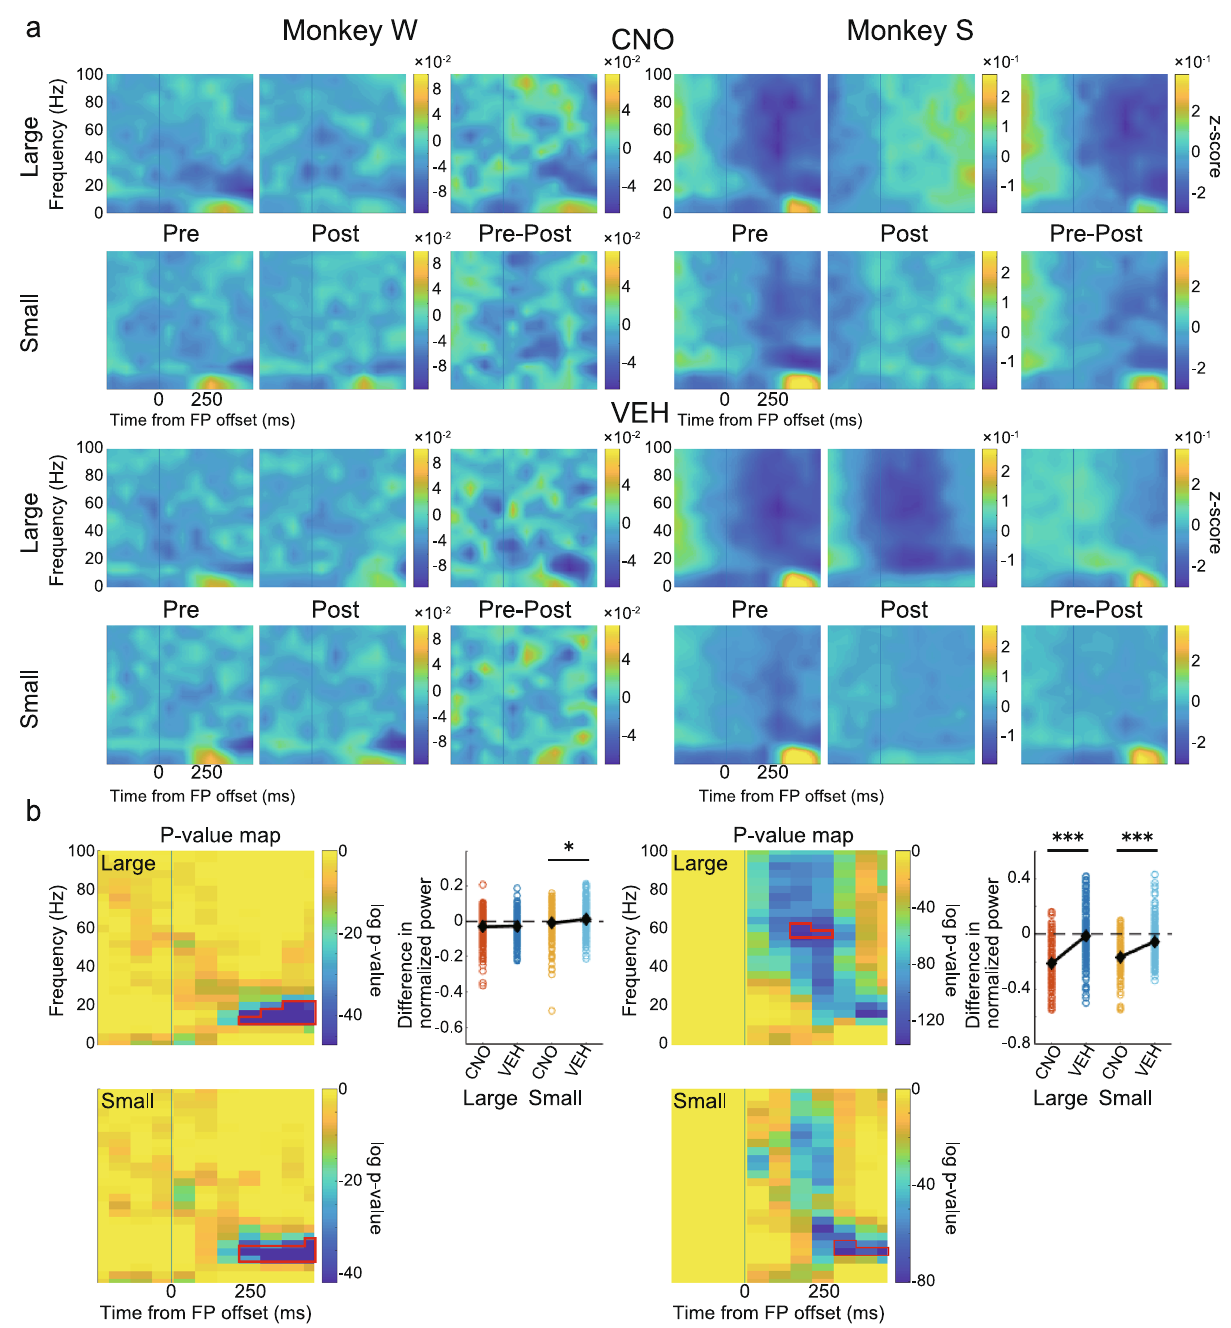
Fig. 8 Effects on spectrogram power in the CdN after the go signal. a Normalized and averaged spectrograms of LFPs from electrodes in the CdN for Monkey W (left) and Monkey S (right). All features in this panel are the same as in Fig. 7a. b For each monkey: left: p -value maps made to extract ROIs with a negative component; right: comparison of the effects of CNO/VEH administration. All features in this panel are the same as in Fig. 7b. CdN caudate nucleus, CNO clozapine N-oxide, VEH vehicle, LFP local fi eld potential, ROI region of